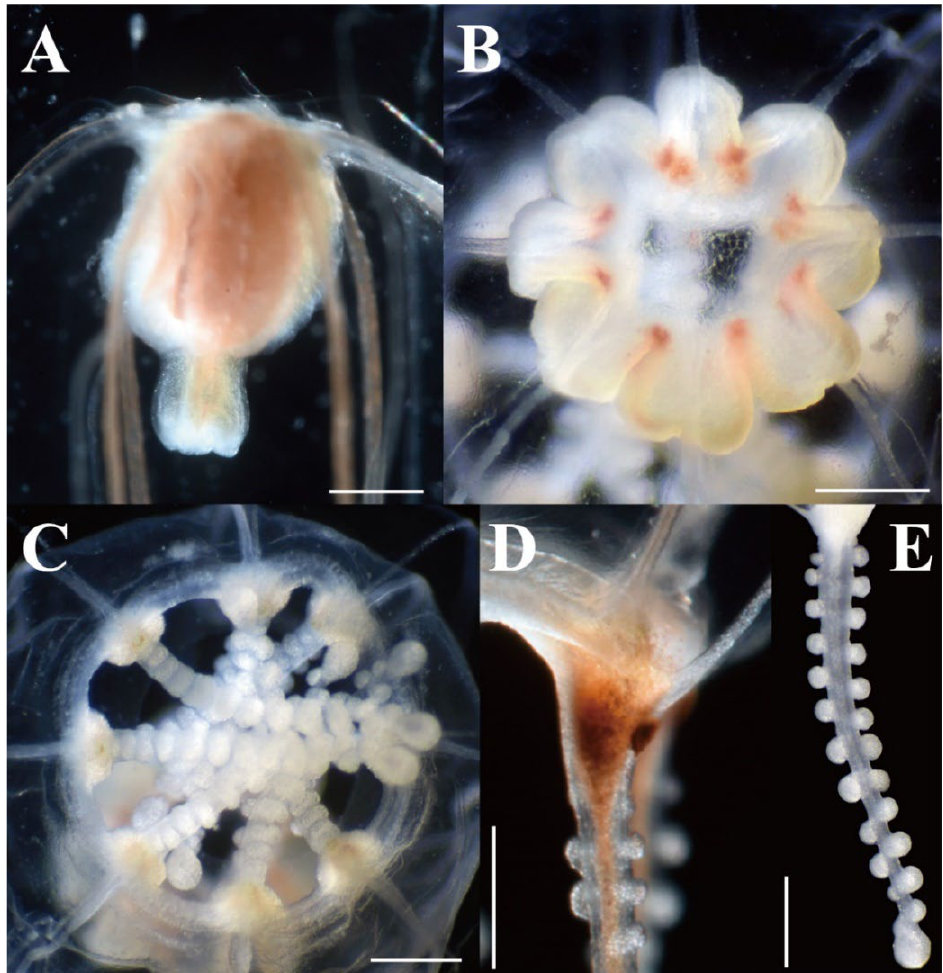
Figure 5. Preserved mature medusae of Octorhopalona saltatrix sp. nov. (NSMT-Co1802): ( A ) lateral, ( B ) apical, and ( C ) oral views. Scale bars: 1 mm.